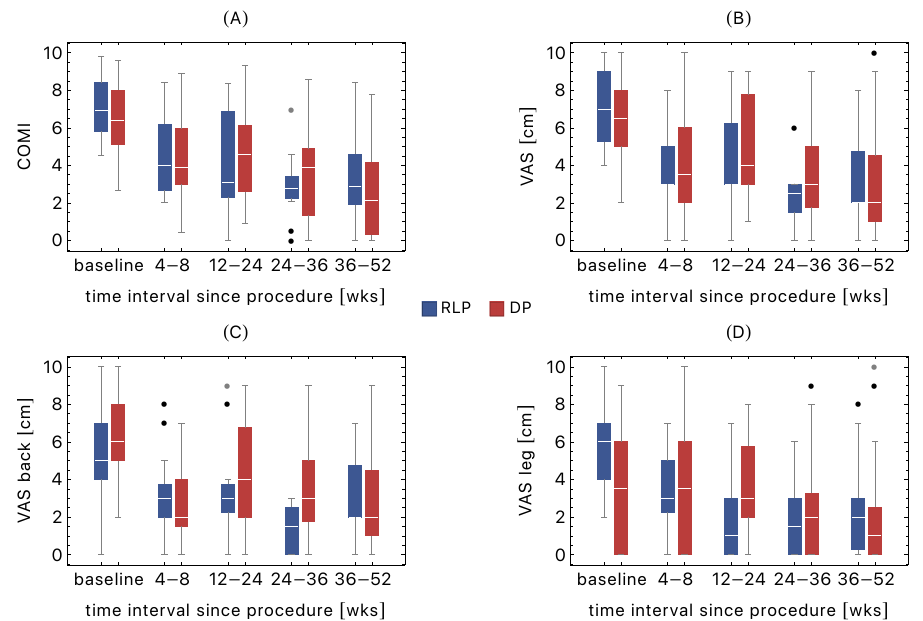
Figure 5. Boxplots of COMI ( A ), VAS ( B ), VAS back ( C ), and VAS leg ( D ) at baseline and four follow- ups: F1 (4–8 wks), F2 (12–24 wks), F3 (24–36 wks), and F4 (36–52 wks). The data are presented for radiculopathy (RLP) and discogenic pain (DP) groups. The black and grey dots correspond to the outliers and far outliers, respectively.